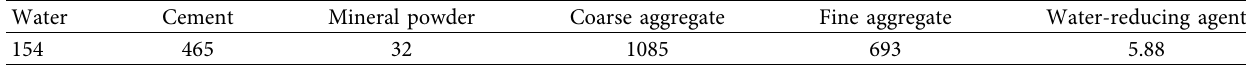
Table 1: Mix proportions (kg/m 3 ).